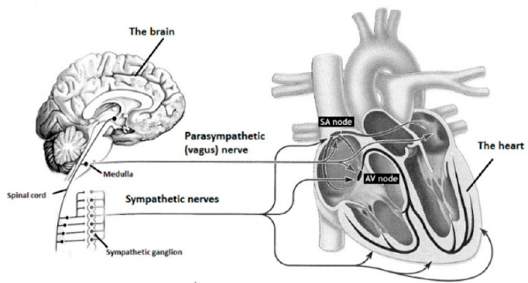
Figure 3. Autonomic nervous system controls different target organs via parasympathetic and sympathetic nerve cords. The parasympathetic nerve controlling the hearts is called the vagus nerve.